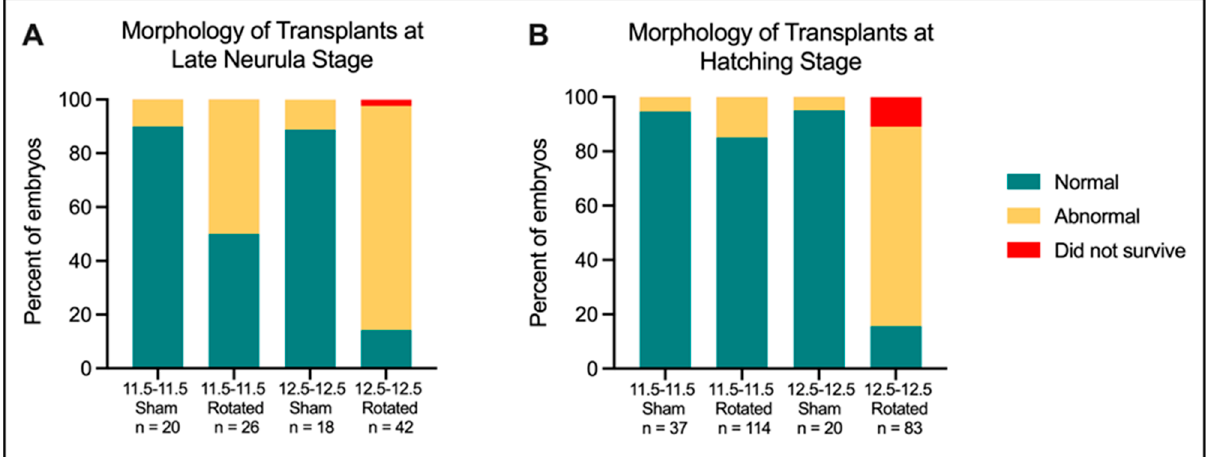
Figure 4. Morphology of embryos with transplanted tissues at late neurula (St. 18) ( A ) and hatching stages (St. 30) ( B ).